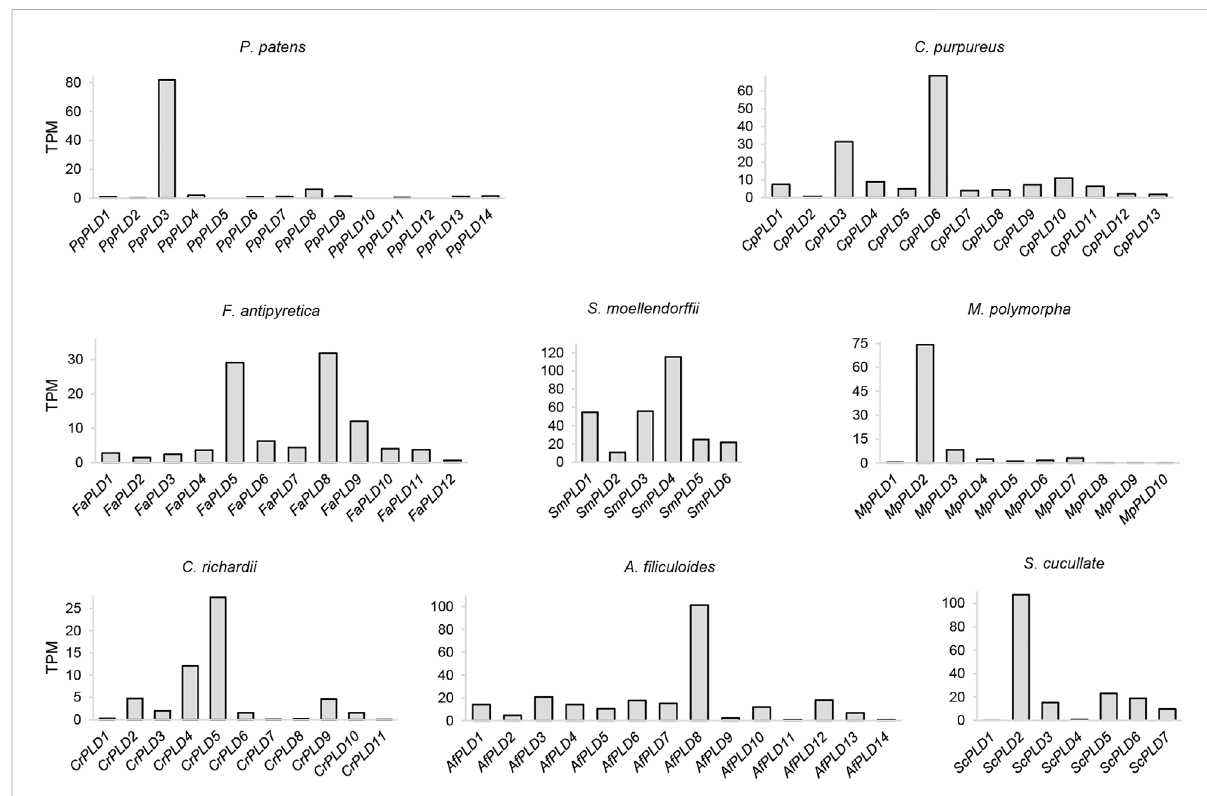
FIGURE 6 Expression pro fi les of the moss, clubmoss, liverwort, and fern PLDs . This fi gure is based on data collected from different RNA-seq experiments and demonstrates the expression of PLDs for each species regardless of the tested conditions. The expression value is not intended for comparison among species. TPM: transcripts per million. The BioProject IDs of the transcriptome experiments are listed in Supplementary Table